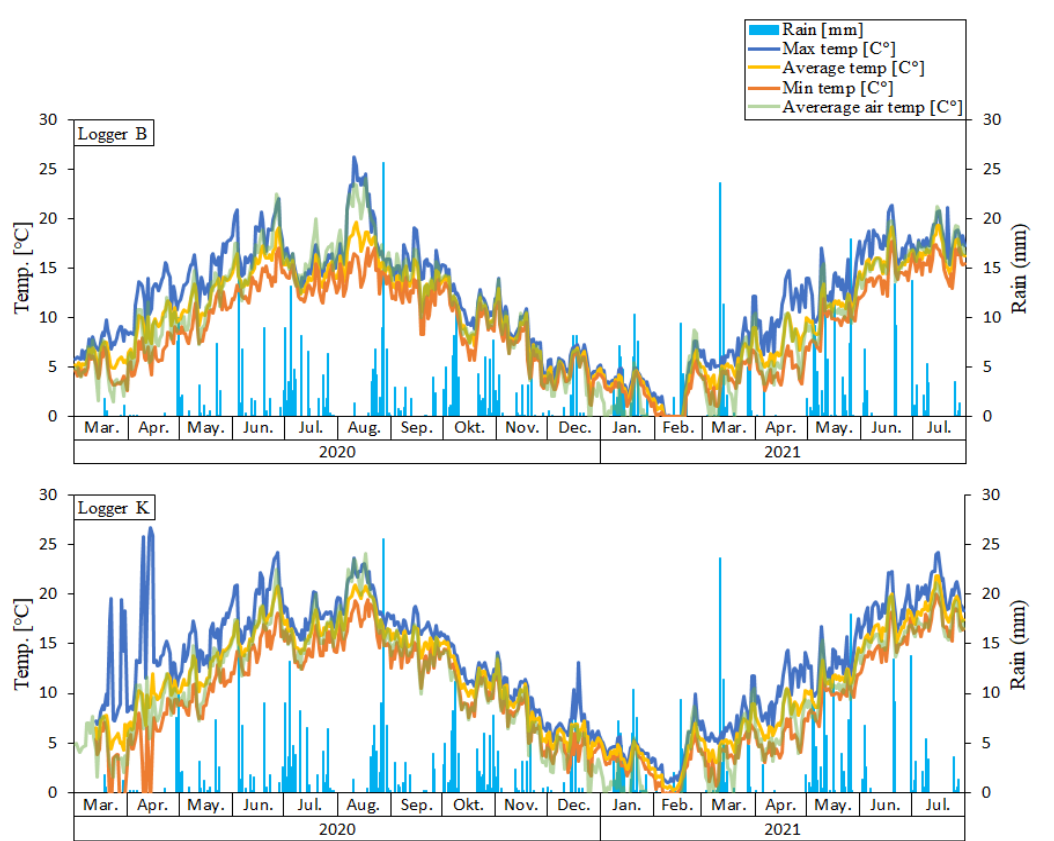
Figure 4. Variations in water temperature [°C] presented as the average (yellow), minimum (orange), and maximum (dark blue) temperature, rain [mm] (light blue), and average air temperature [°C] (green—50% transparent) per day at station B and station K.